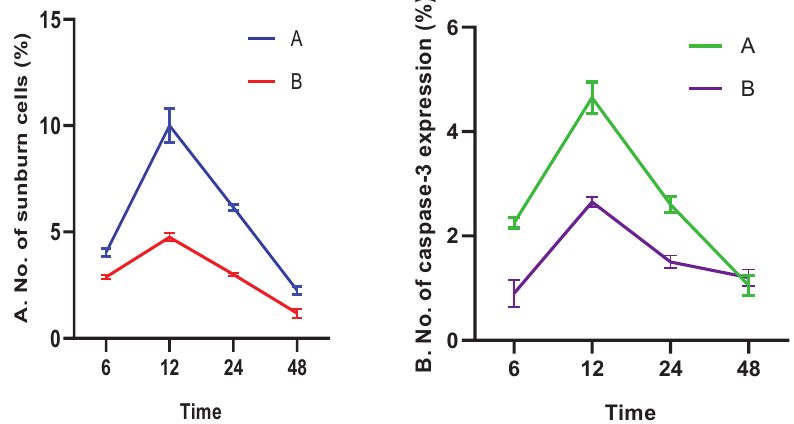
Figure 3. A. Time Dependent Effect of UVB Irradiation on SBC. B. Time dependent effect of UVB irradiation on caspase-3